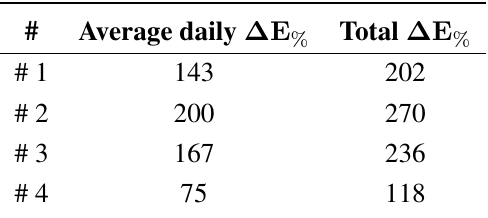
Table 8. Result of calculations of ∆ E for 14 days. E is calculated with velocity telemac,i data from the TELEMAC simulation, extracted from four different positions in the channel. Positive values indicate that E is higher than ˆ E . telemac,i